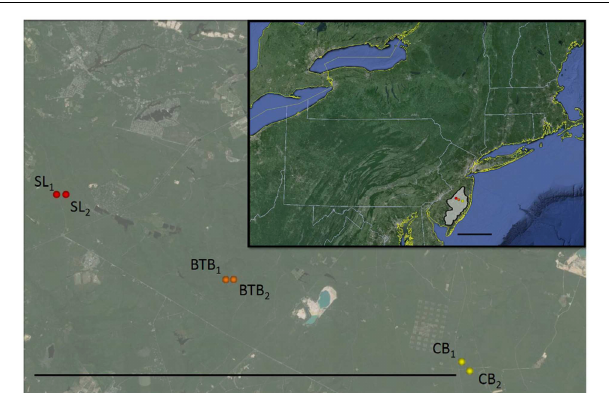
FIGURE 1 | Location of the New Jersey Pinelands National Reserve (in inset, shaded in gray; scale bar = 100km) and locations of Silas Little (SL; in red), Brendan T Byrne (BTB; in orange), and Cedar Bridge (CB; in yellow) sites. Scale bar on magnified map = 20km. Map data: Image NOAA, Image Landsat, Data SIO, NOAA, U.S. Navy, NGA, GEBCO, © 2015